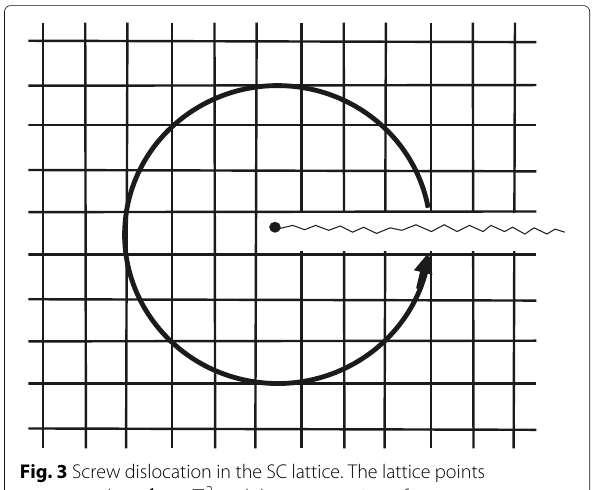
Fig. 3 Screw dislocation in the SC lattice. The lattice points correspond to A p ⊂ E 2 and the center point refers to z 0